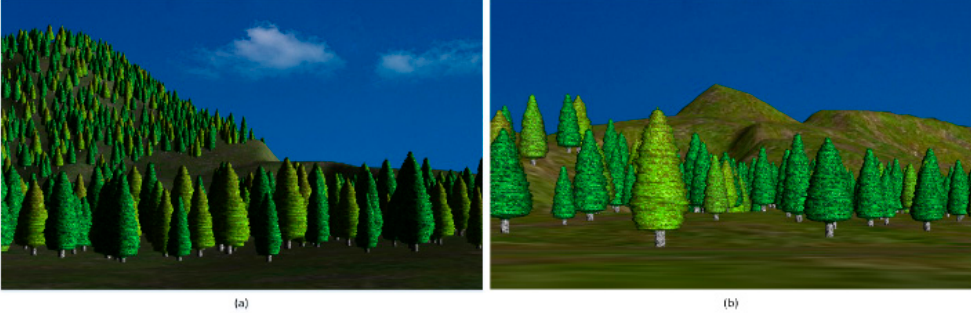
Figure 19. ( a ) A grove scene viewed from distance; ( b ) the rendering result of the same scene viewed from another direction.